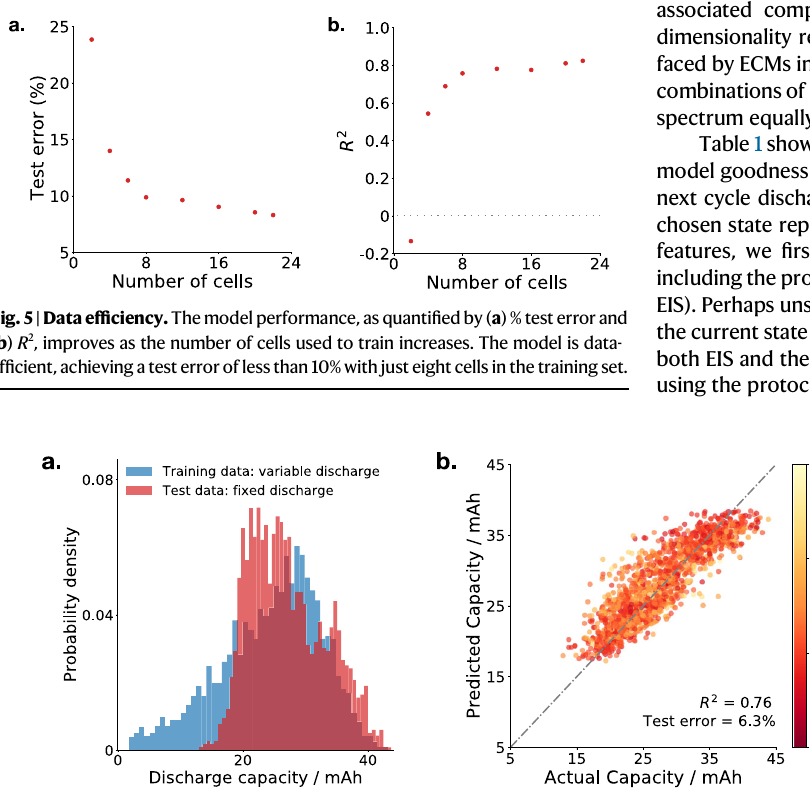
colour of the plotted points denotes predicted uncertainty (see colour bar). c The model `knows what it does not know': when we restrict the test data used to calculate the root-mean squared error (RMSE) by including only the predictions thatthemodelismostcon fi dentabout(i.e.withlowestpredictiveuncertainty),the RMSE